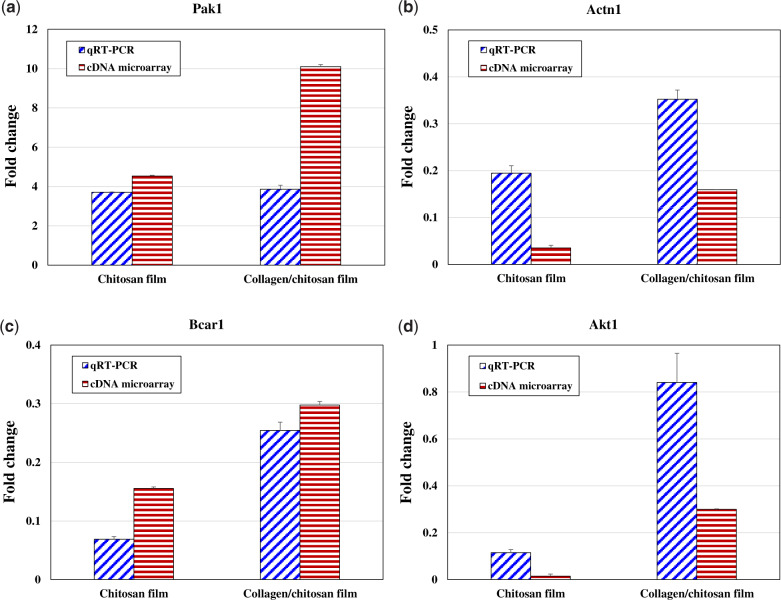
Comparison of the expression levels [(a) Pak1, (b) Actn1, (c) Bcar1 and (d) Akt1] in the qRT-PCR and the cDNA microarray experiments